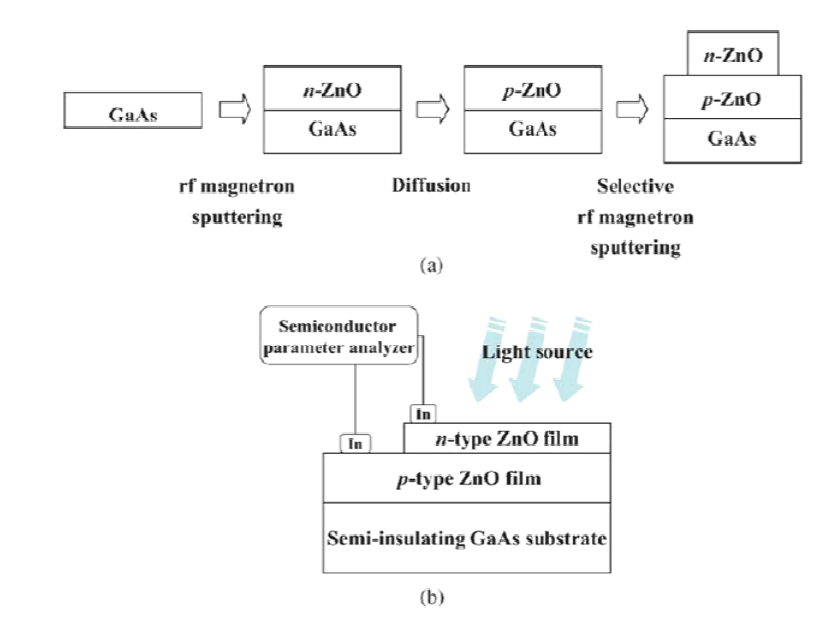
Figure 10. Schematic (a) procedure to fabricate a ZnO p–n homojunction and (b) illustration of a ZnO p–n homojunction which had indium electrodes